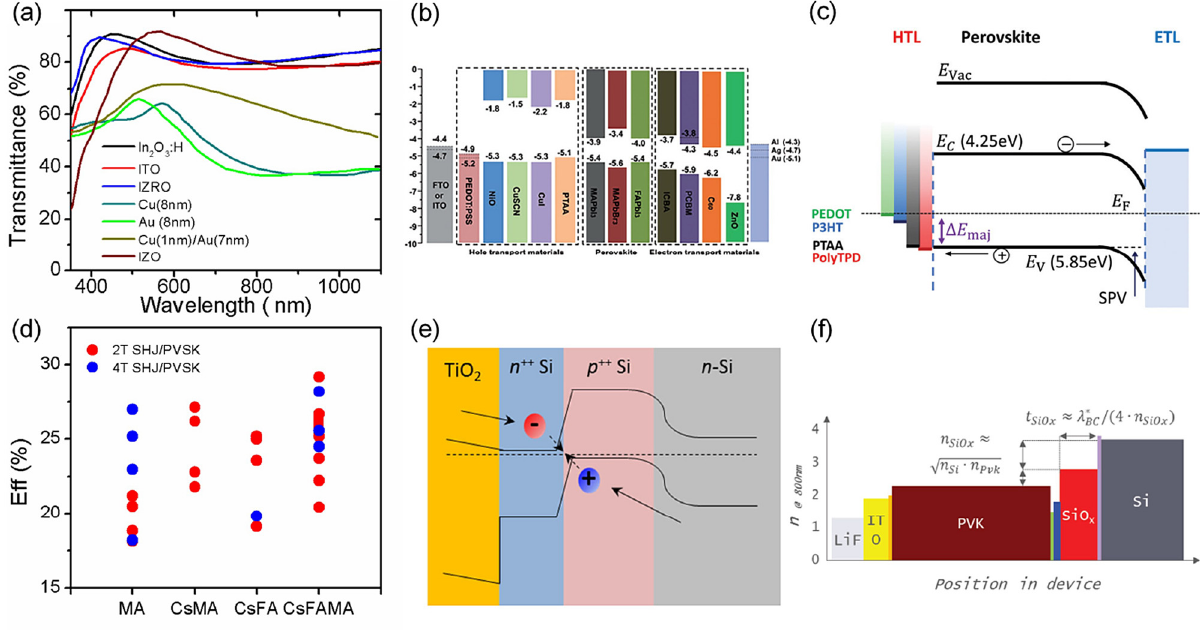
Figure 5: (a) Transmittance ( T ) of differenttransparent electrodes: In 2 O 3 :H [68],ITO [68], Zr-dopedindiumoxide (IZRO)[71], Cu (8 nm)